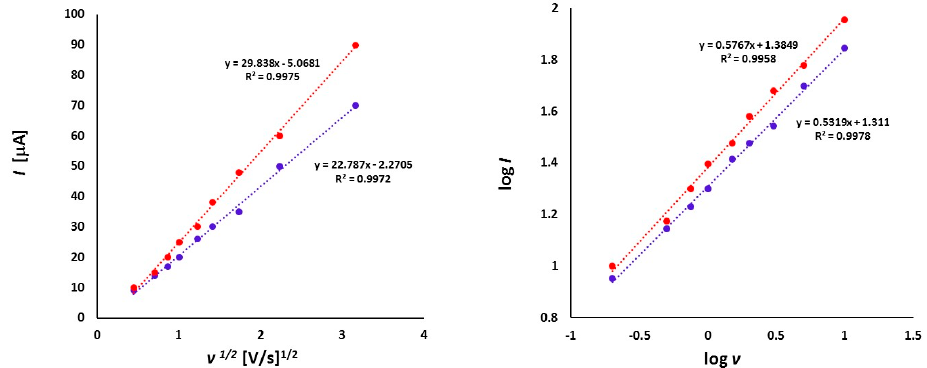
Figure 6. The dependence of the peak currents ( I ) from the square root of scan rate ( v 1/2 ) ( left ) and logarithm of peak currents (log I ) versus logarithm of scan rates (log v ) ( right ) for 1a (1.0 mmol/L) in CH 2 Cl 2 - [ n Bu 4 N][BF 4 ] solution (0.1 m/L).